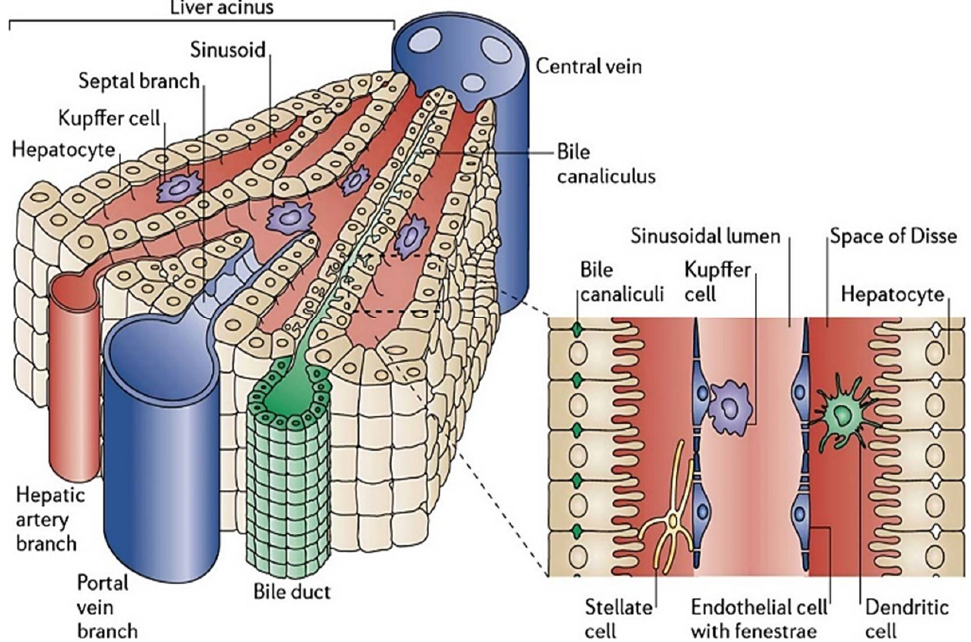
Figure 1. Structures of the liver lobule and liver sinusoids. Hepatocytes are aligned radially to form the liver plate along with the sinusoids. The portal veins and hepatic artery branches terminate in the sinusoids, draining blood into the sinusoids and through the acinus to the central vein. The sinusoids are lined by fenestrated liver sinusoidal endothelial cells with Kupffer cells interspersed onto the endothelium. Between the liver plate and the sinusoids is the space of Disse, containing extracellular matrix components and hepatic stellate cells [5]. matrix components and hepatic stellate cells